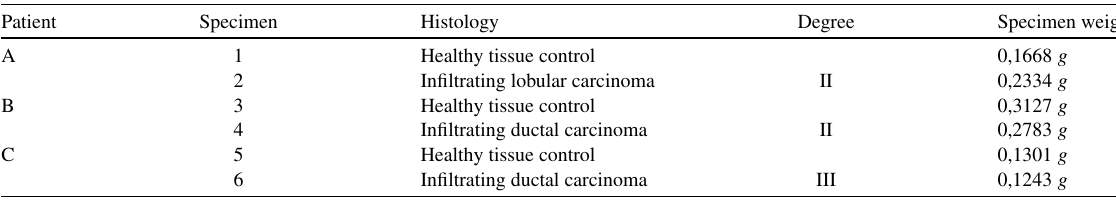
Specimens features